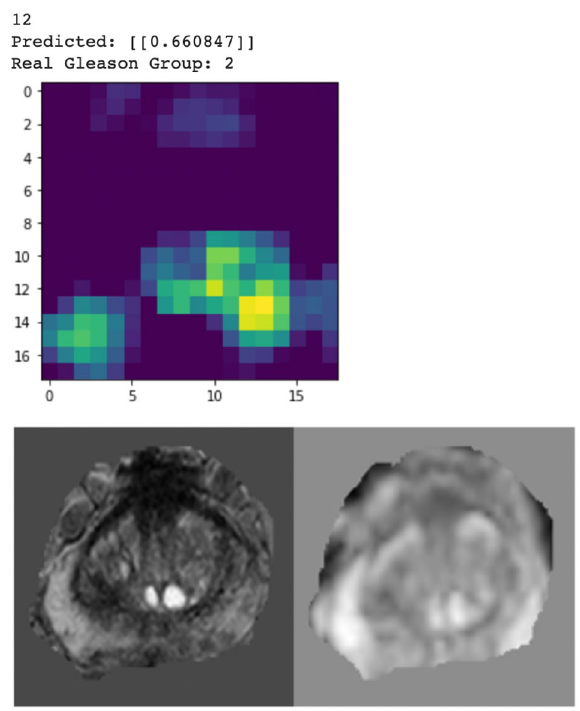
Figure 9. Grad-CAM from the CG-detector indicating PZ-detector and CG-detector were both sensitive to Slice 12 for Patient WN 00005, which showed hyper-intense signal in both PZ and